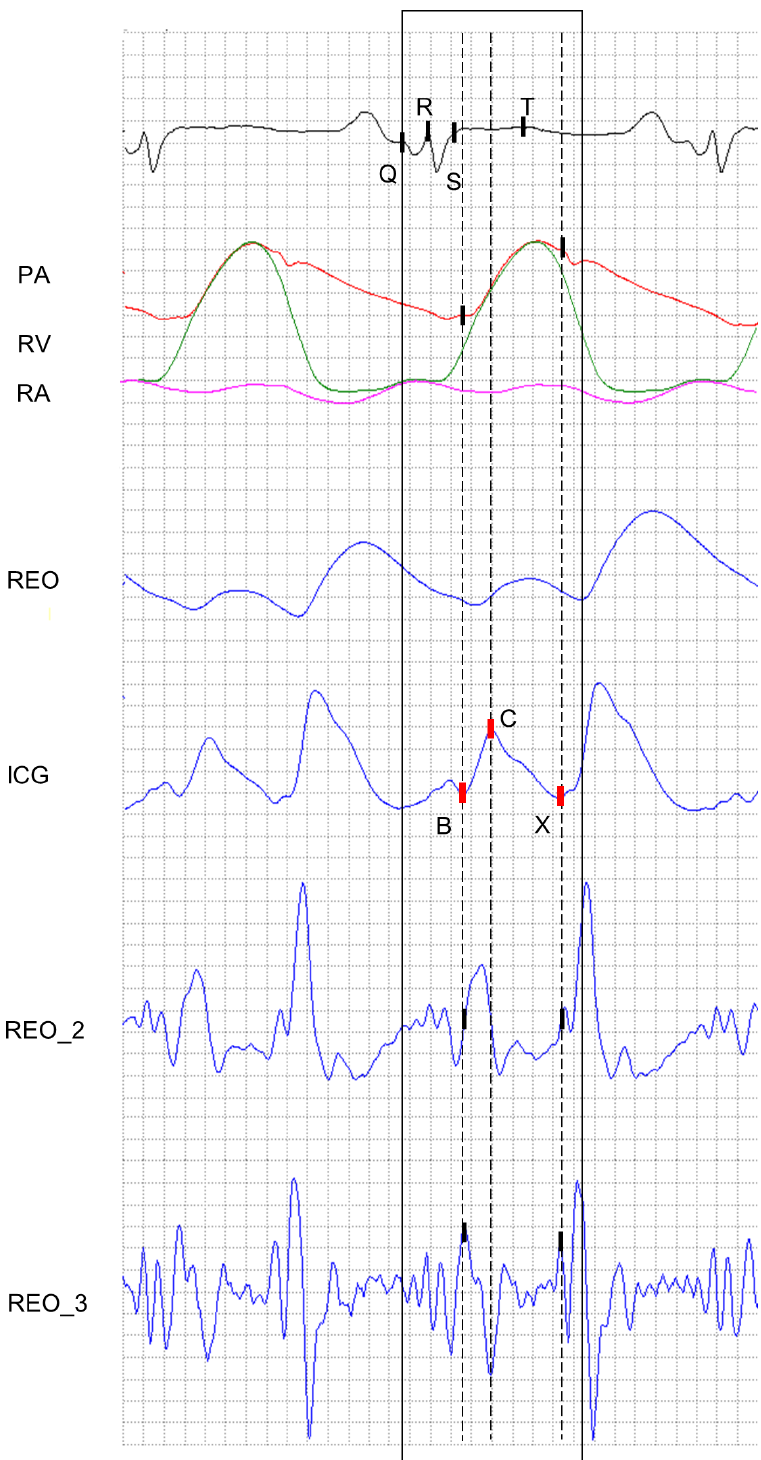
Figure 2. Example of signals registered during one cardiac cycle. The first signal from above illustrates the ECG signal along with its characteristic points: Q, R, S, and T. The next picture presents the pressures in the pulmonary artery (PA), right atrium (RA), and right ventricle (RV). The following waveform depicts the cardiography impedance signal and its corresponding derivatives: dZ d 2 Z ( REO_2 ) and d 3 Z ( REO_3 ). The rectangle denotes the time window used during the identification dt 2 dt 3 of the characteristic points in the ICG